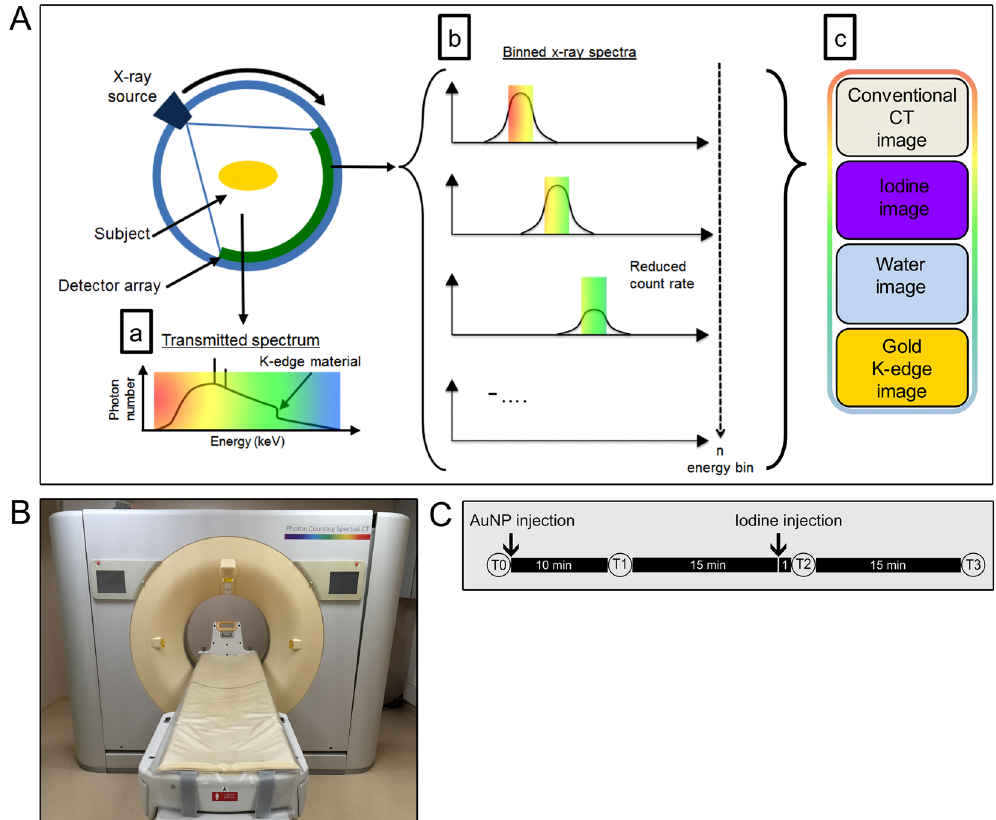
Figure 1. ( A ) Schematic depiction of SPCCT image formation. The transmitted spectrum (a) is divided by photon-counting detectors into multiple bins (b). These datasets are jointly processed to provide conventional images, and specific material decomposition images, e.g. water, iodine and gold images (c). ( B ) Photograph of the spectral photon-counting CT system used in this study. ( C ) Schematic depiction of the in vivo imaging